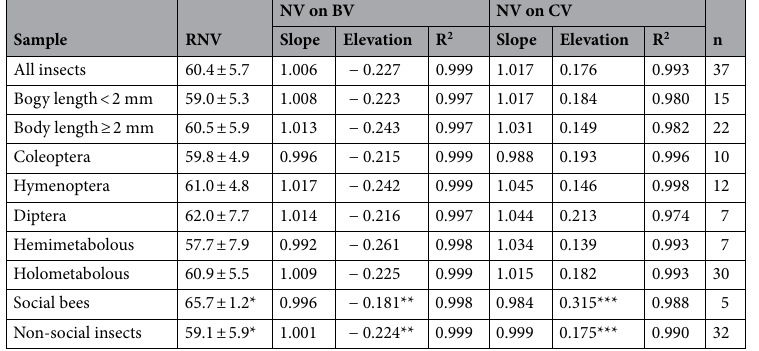
Table 2. Comparison of neuropil volumes in different groups of insects. Relative neuropil volume to brain volume (RNV, Mean % ± SD). Slope, elevation, and R 2 from SMA allometric analysis of dependence of neuropil volume (NV) on brain volume (BV) and cell body rind volume (CV) (log); n is the number of species in sample; * RNV significantly different between sample(ANOVA p = 0.033); ** and *** significantly different elevations (elev.com p = 0.015 and 0.019,